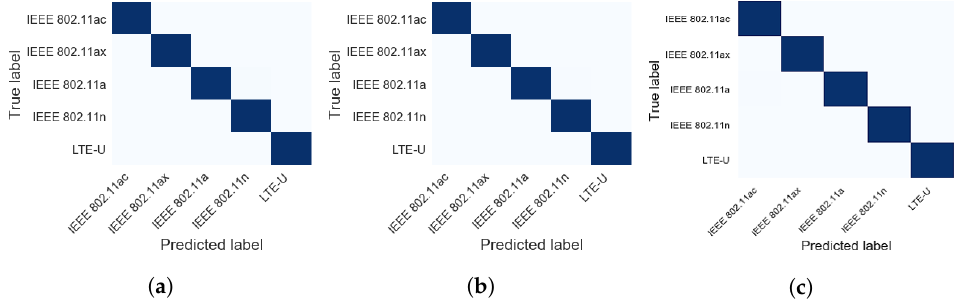
Figure 7. Confusion matrices for CNN3+AE in some representative SNR levels and channel scenarios: ( a ) SNR 5 dB and scenario 5 ; ( b ) SNR 15 dB and scenario 3 ; ( c ) SNR 20 dB and scenario 2